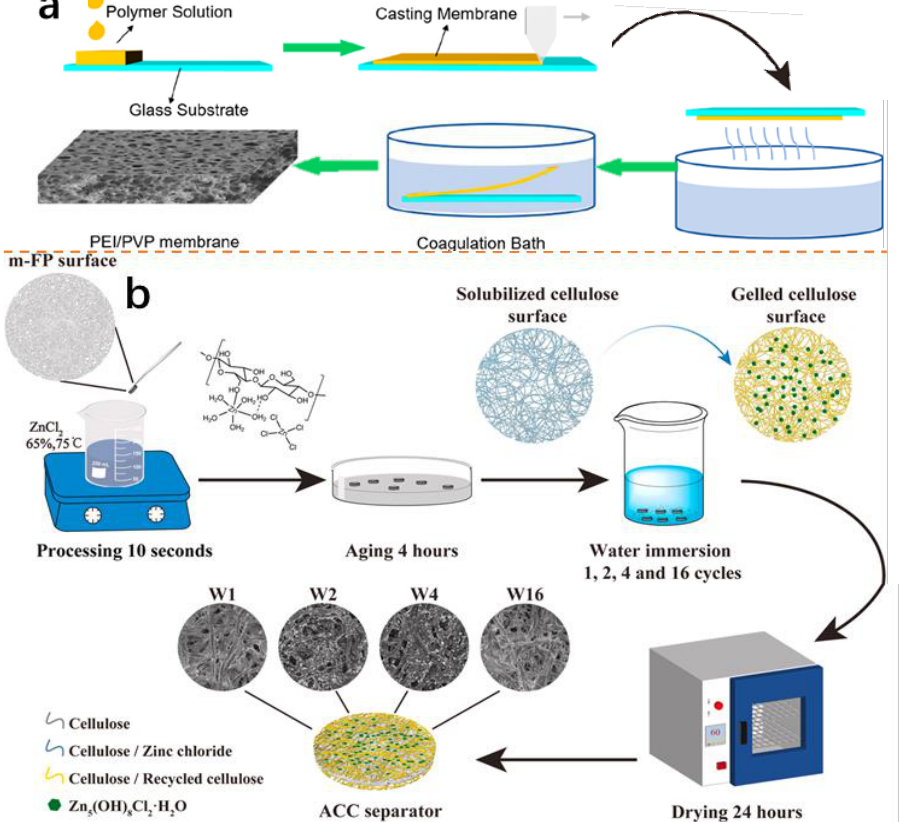
Figure 9. ( a ), Preparation process of PEI/PVP separators (Copyright, American Chemical Society 2021). ( b ) Preparation process of ACC separators (Copyright, Elsevier 2021).